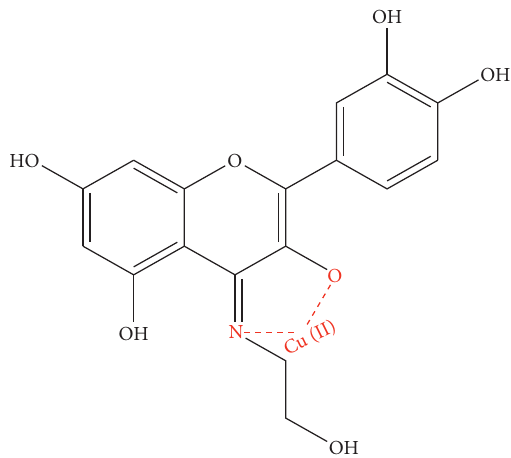
Figure 6: Possible structure of the complex.